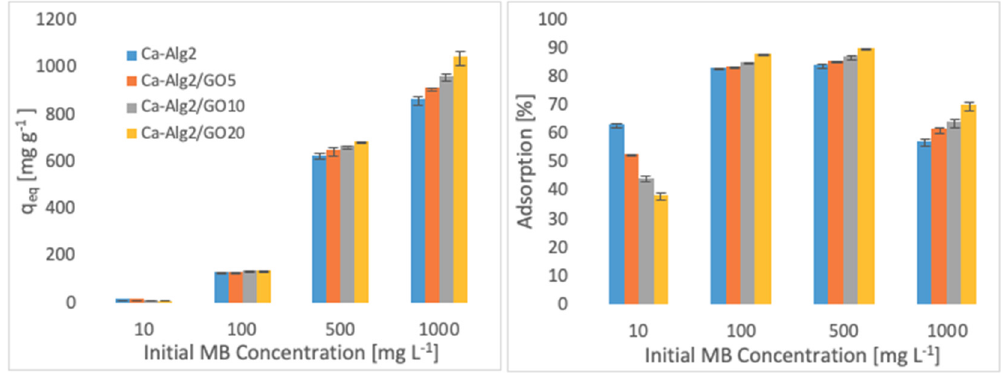
Figure 4. Effect of the initial MB concentration on q eq and adsorption percentage.